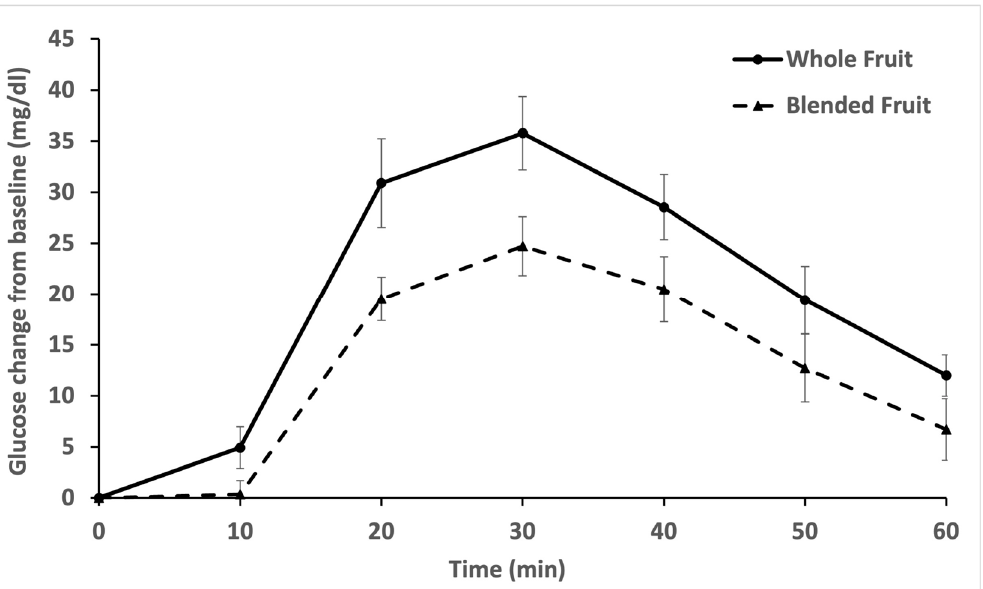
Figure 1. Mean incremental blood glucose values subtracted from baseline blood glucose values from 20 participants over 60 min, after consuming either whole fruit (solid line) or blended fruit (broken line). Error bars represent standard error of the mean (SEM). Table 1. Mean glycemic response values ± SEM, with baseline glycemic values subtracted from incremental glycemic values, from 20 participants after consuming either whole fruit or blended fruit.